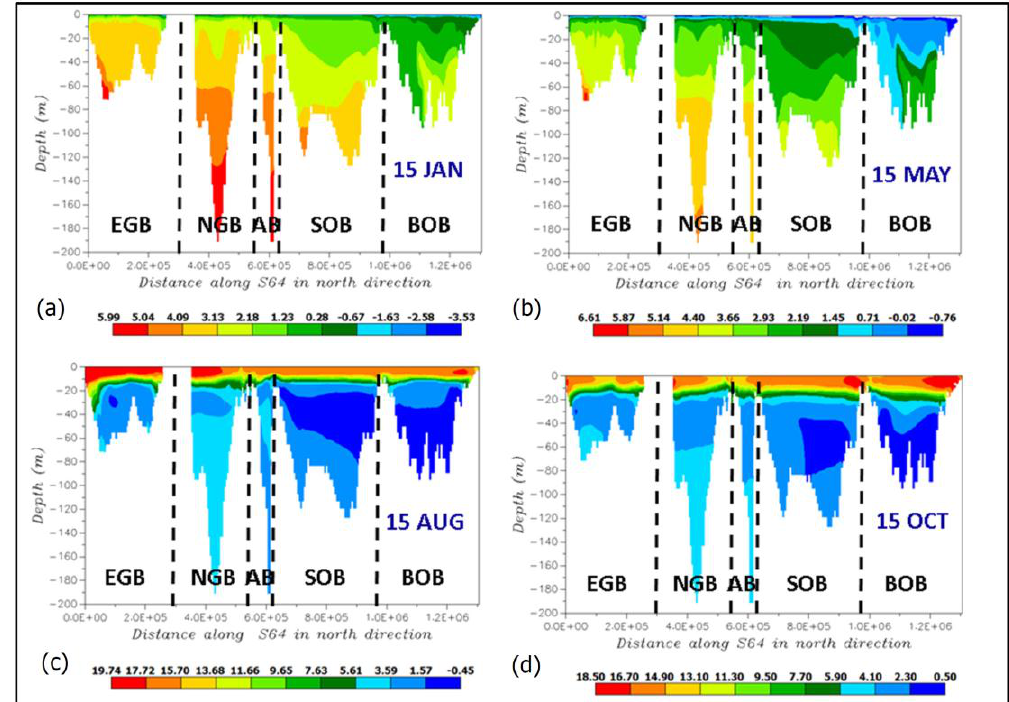
Figure 13. Seasonal thermal stratification plots in the Baltic Sea at cross section S64 for the year 2000. ( a ) Winter; ( b ) Spring; ( c ) Summer; ( d ) Autumn.